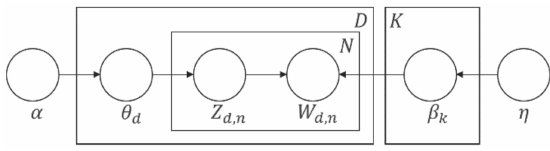
Figure 2. Topic modeling